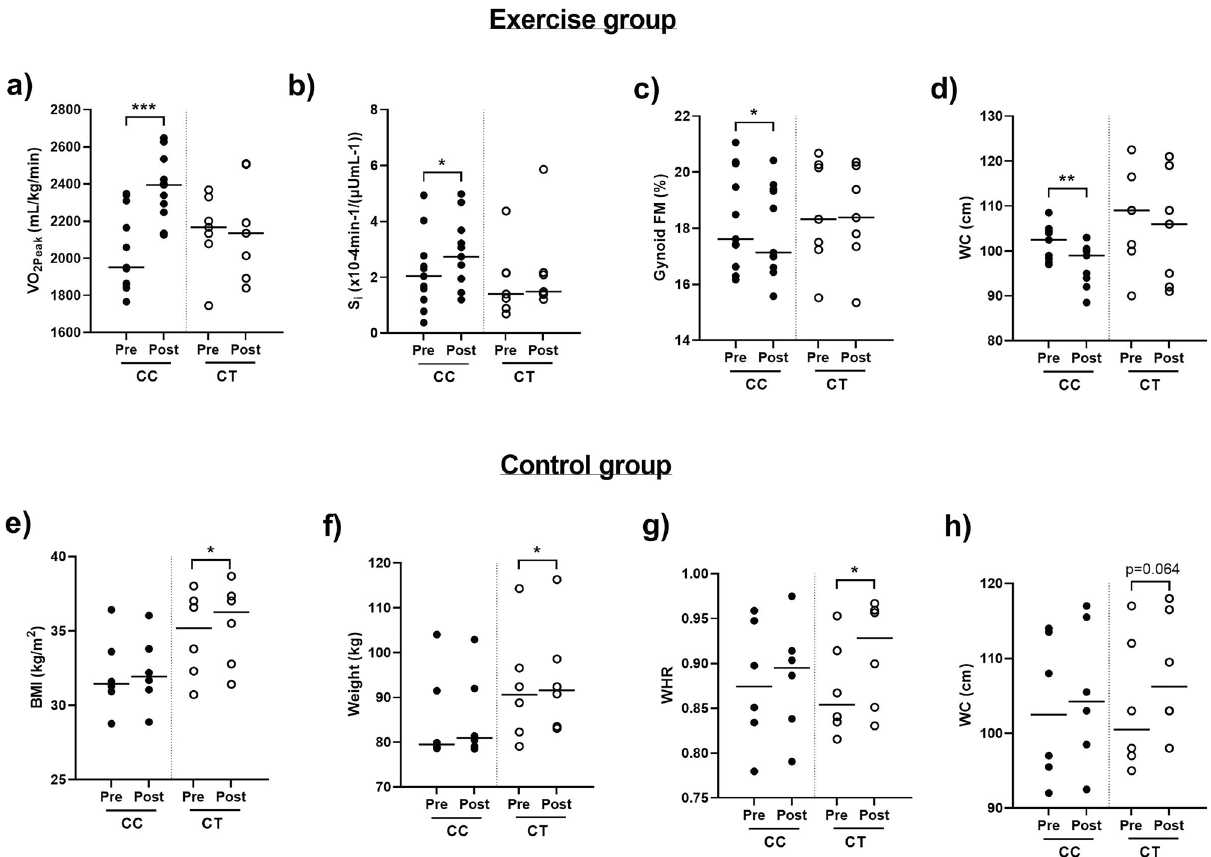
Figure 5. Individual changes in VO 2peak ( a ), waist circumference (WC) ( b ), gynoid fat mass % (FM) ( c ) and insulin sensitivity (S I ) ( d ) in exercise group (n = 19, CC n = 11, CT n = 7) and body mass index (BMI) ( e ), weight ( f ), waist to hit ratio (WHR) ( g ) and WC ( h ) in control group (n = 12, CC n = 6, CT n = 6) pre- and post-intervention. Thick black line–median, shaded circles-CC genotype, empty circles–CT genotype. * p < 0.05, ** p < 0.01, *** p <